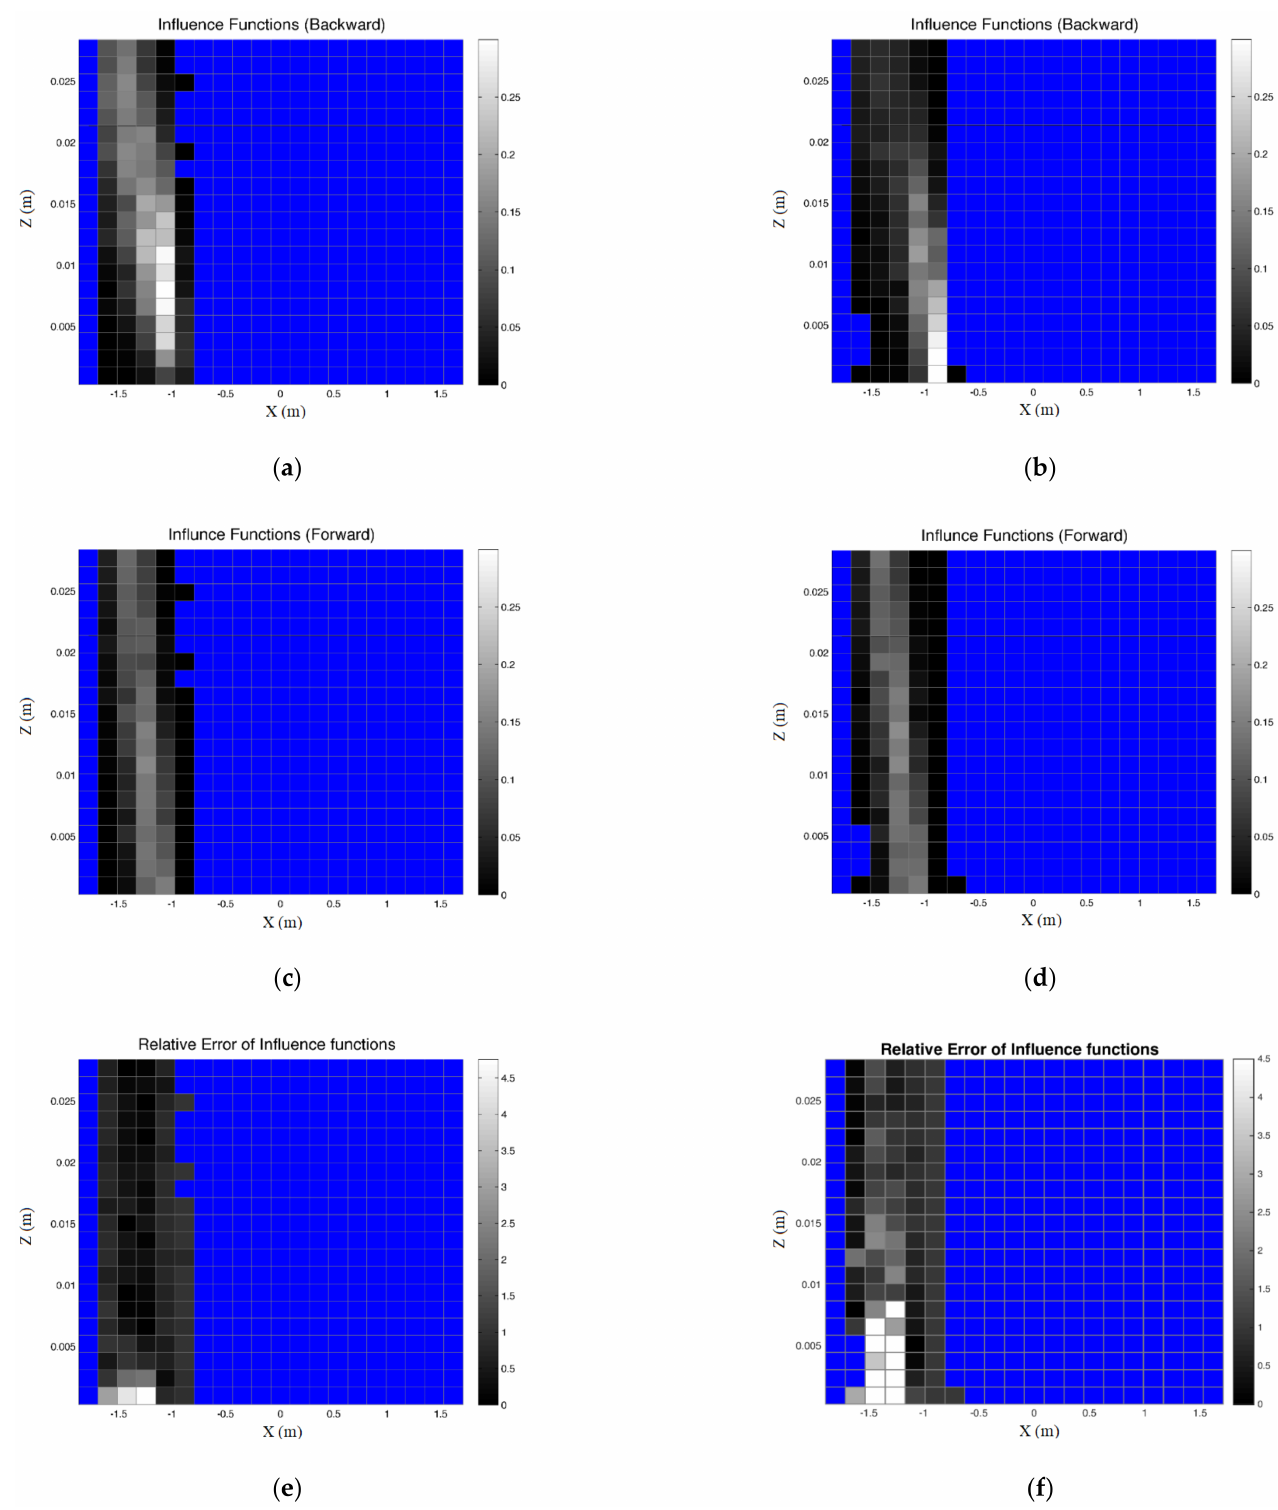
Figure 15. Backward and forward influence functions, and relative error. ( a ) Backward influence function with explicit method; ( b ) backward influence function with implicit method; ( c ) forward influence function with explicit method; ( d ) forward influence function with implicit method; ( e ) relative error with explicit method; ( f ) relative error with implicit